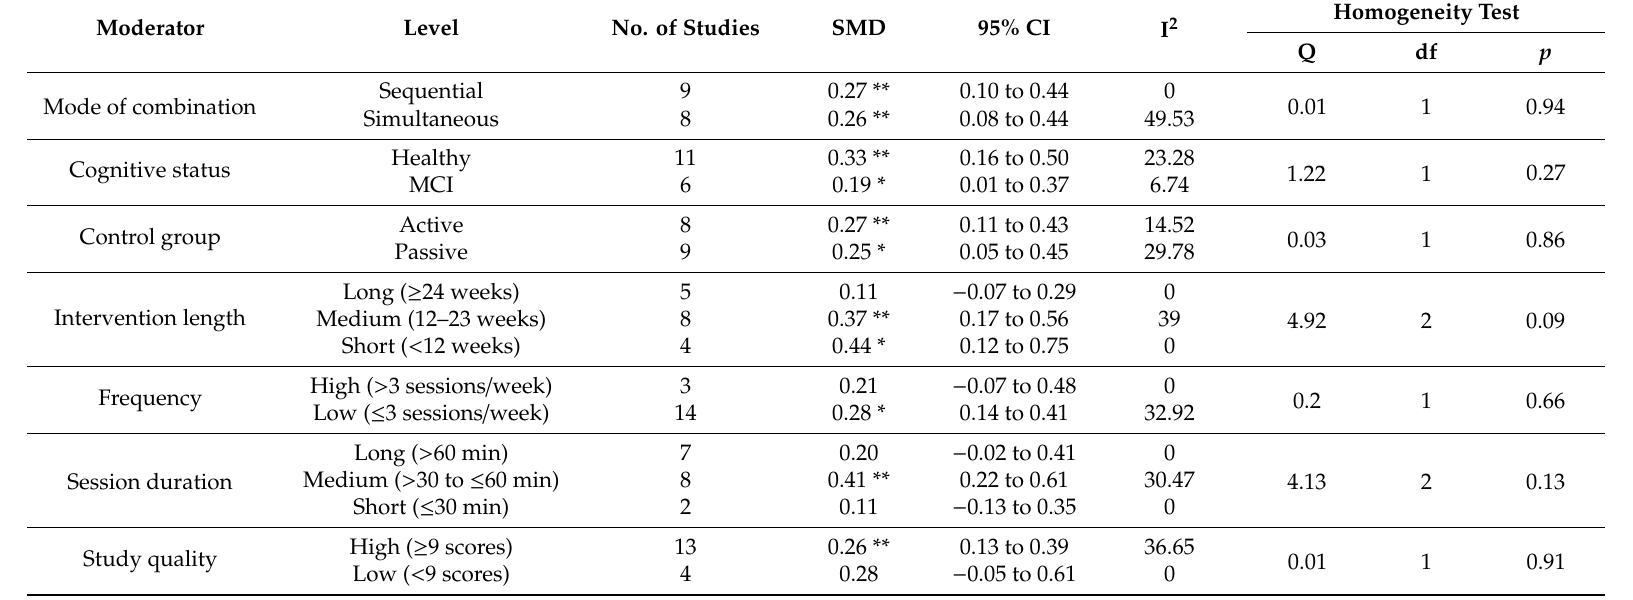
Table 3. Moderator Analysis for the Combined Intervention Group vs. the Control